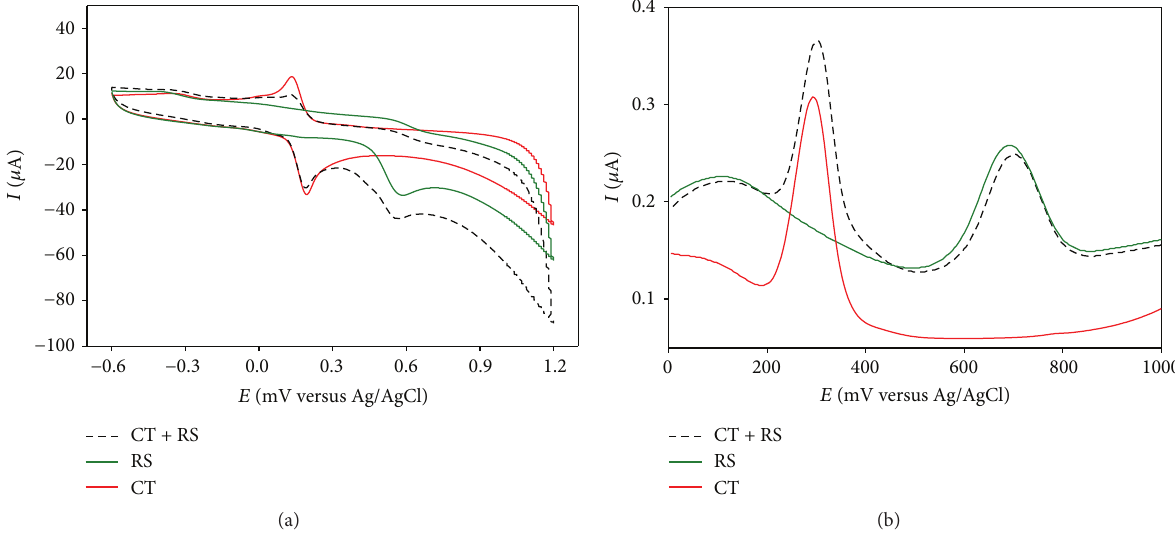
Figure 3: Overlay of (a) CV and (b) DPV responses of individual (solid lines) and mixture (dashed line) of CT and RS in PBS at PGA modified